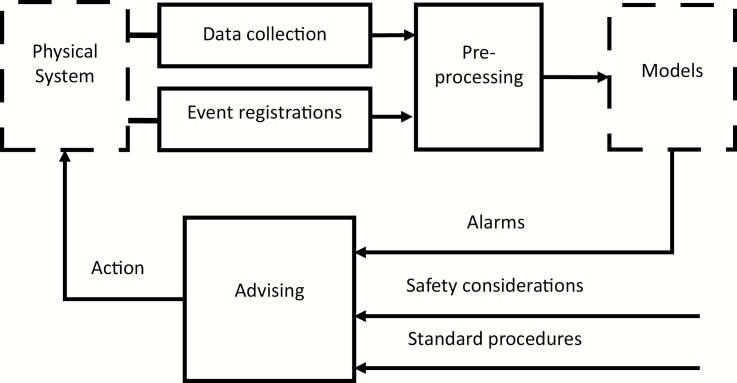
The basic idea of a model-based monitoring system (Jensen, 2016).